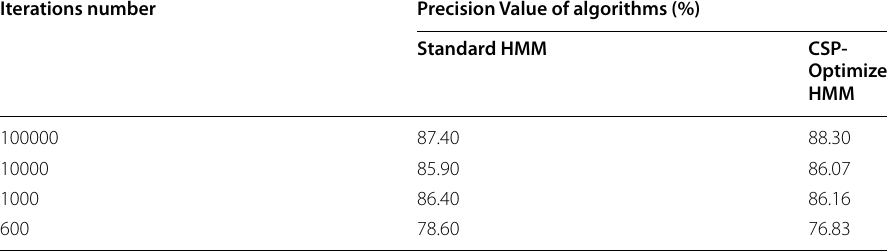
Table 8 Precision values